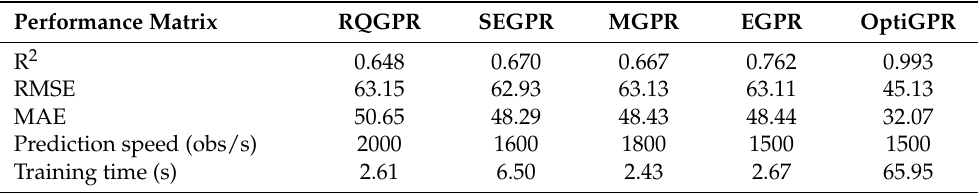
Figure 2. ( a ) Dispersion plots showing the comparison between the actual and the RQGPR-predicted bioethanol. ( b ) Regression plots showing the observed and RQGPR-predicted bioethanol. Table 3. Performance matrix of the various models.